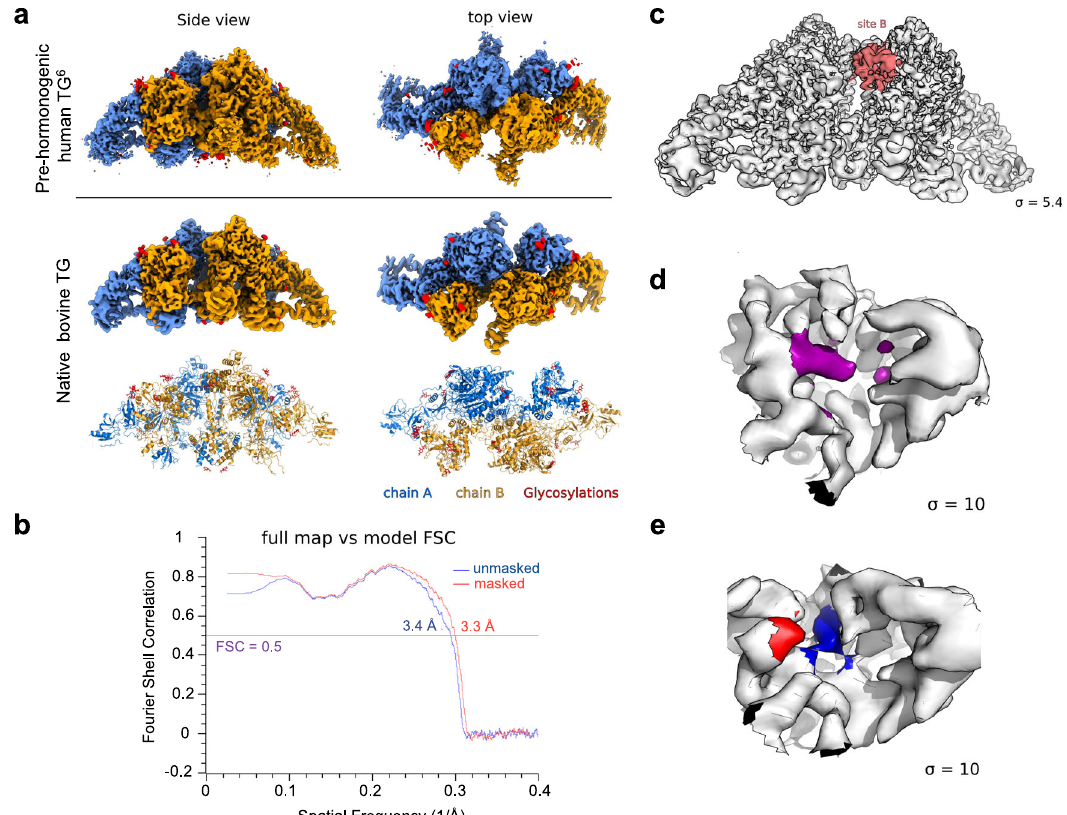
Fig. 3 Global reconstruction of native bovine TG and initial density map for hormonogenic site B. a Upper and middle rows show, respectively, global reconstructions of pre-hormonogenic TG (from ref. 6 ) and the present analysis of native bovine TG (derived from the combined C2 map) color-coded as in Fig. 1; lower panel shows bovine TG reconstruction in ribbon representation. b FSC curves showing the correlation between the combined C2 density map and the atomic model. c C2 map of bovine TG showing the region encompassing hormonogenic site B (pale red). Sigma, contour level of map. d Detailed view of the density map for site B in native bovine TG. Novel unresolved density extending from the acceptor tyrosine position into an interior pocket is indicated in purple . e Corresponding view of the density map for site B in the pre-hormonogenic structure of human TG 6 . Acceptor and donor tyrosine densities are indicated in red and blue,